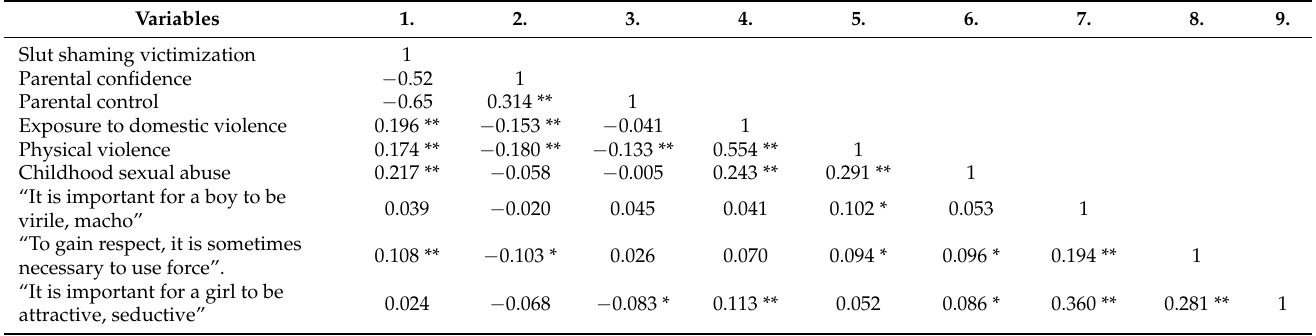
Table 3. Correlation